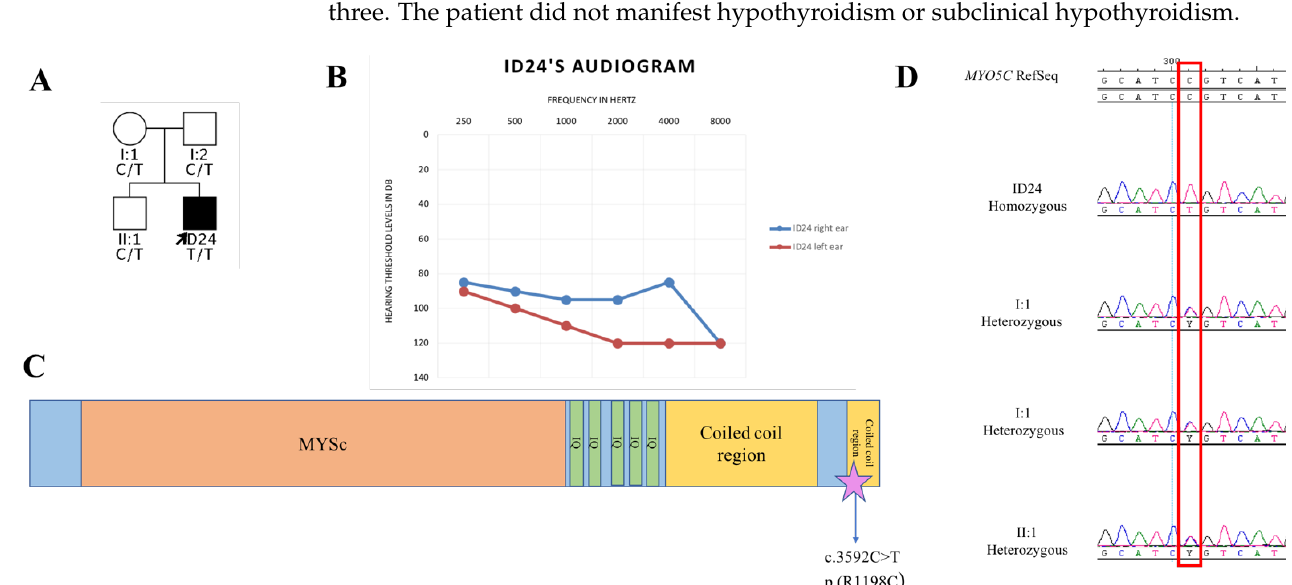
Figure 4. Pedigree and audiograms of patient ID24, DNA chromatograms, and schematic representation of the protein domains ( A ) Pedigree of the proband ID24, which is indicated with a black arrow. Both his parents (I:1 and I:2) and his brother (II:1) carry the variant on MYO5C (NM_018728.4, c.3592C>T p.(R1198C)) at the heterozygous state. The genotypes of the four individuals are indicated. The only affected subject is ID24, who therefore is represented with a filled symbol. square: males; circle: females. ( B ) Audiometric features of ID24, displayed as audiograms. The hearing threshold levels of the right ear are reported in blue while those of the left ear are reported in red. ( C ) Schematic representation of myosin-Vc protein domains and the localization of the variant identified in ID24. The MYSc (myosin large ATPase) domain is displayed in orange, in green the five IQ domains, which are formed by short calmodulin-binding motif and finally the coiled coil domains are reported in yellow. A pink star points out the position of the interesting MYO5C variant identified in ID24. ( D ) Chromatograms displaying part of MYO5C sequence. The sequence of ID24 is reported on top, followed by the one of his mother, father, and brother, respectively. The red box indicates the position of the